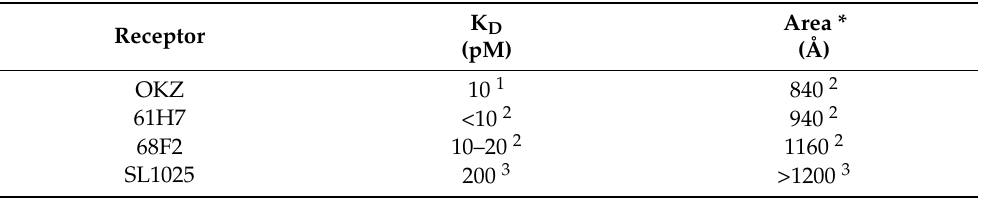
Table 1. IL-6 synthetic receptors analyzed in this paper. The affinity and the area shared with the cytokine, as resolved in the literature, are reported for each of them.